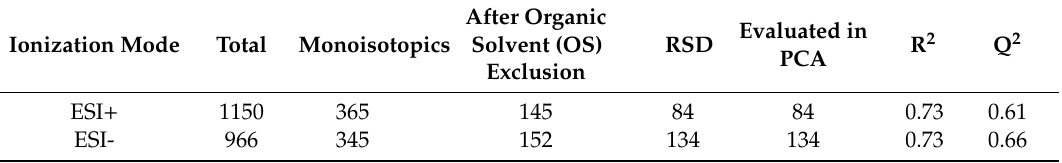
Table 1. Extracted peaks from reverse-phase liquid chromatography (RPLC) positive and negative